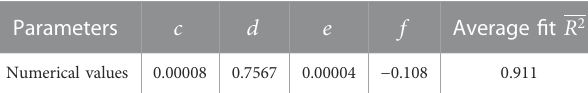
TABLE 6 Fitting parameters of linear